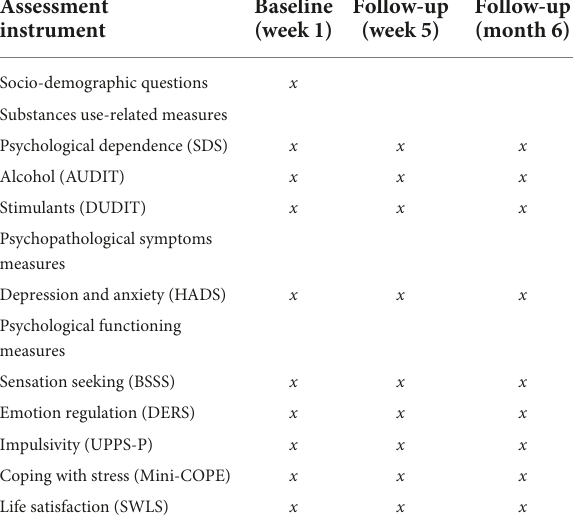
TABLE 2 Timeline of the questionnaire